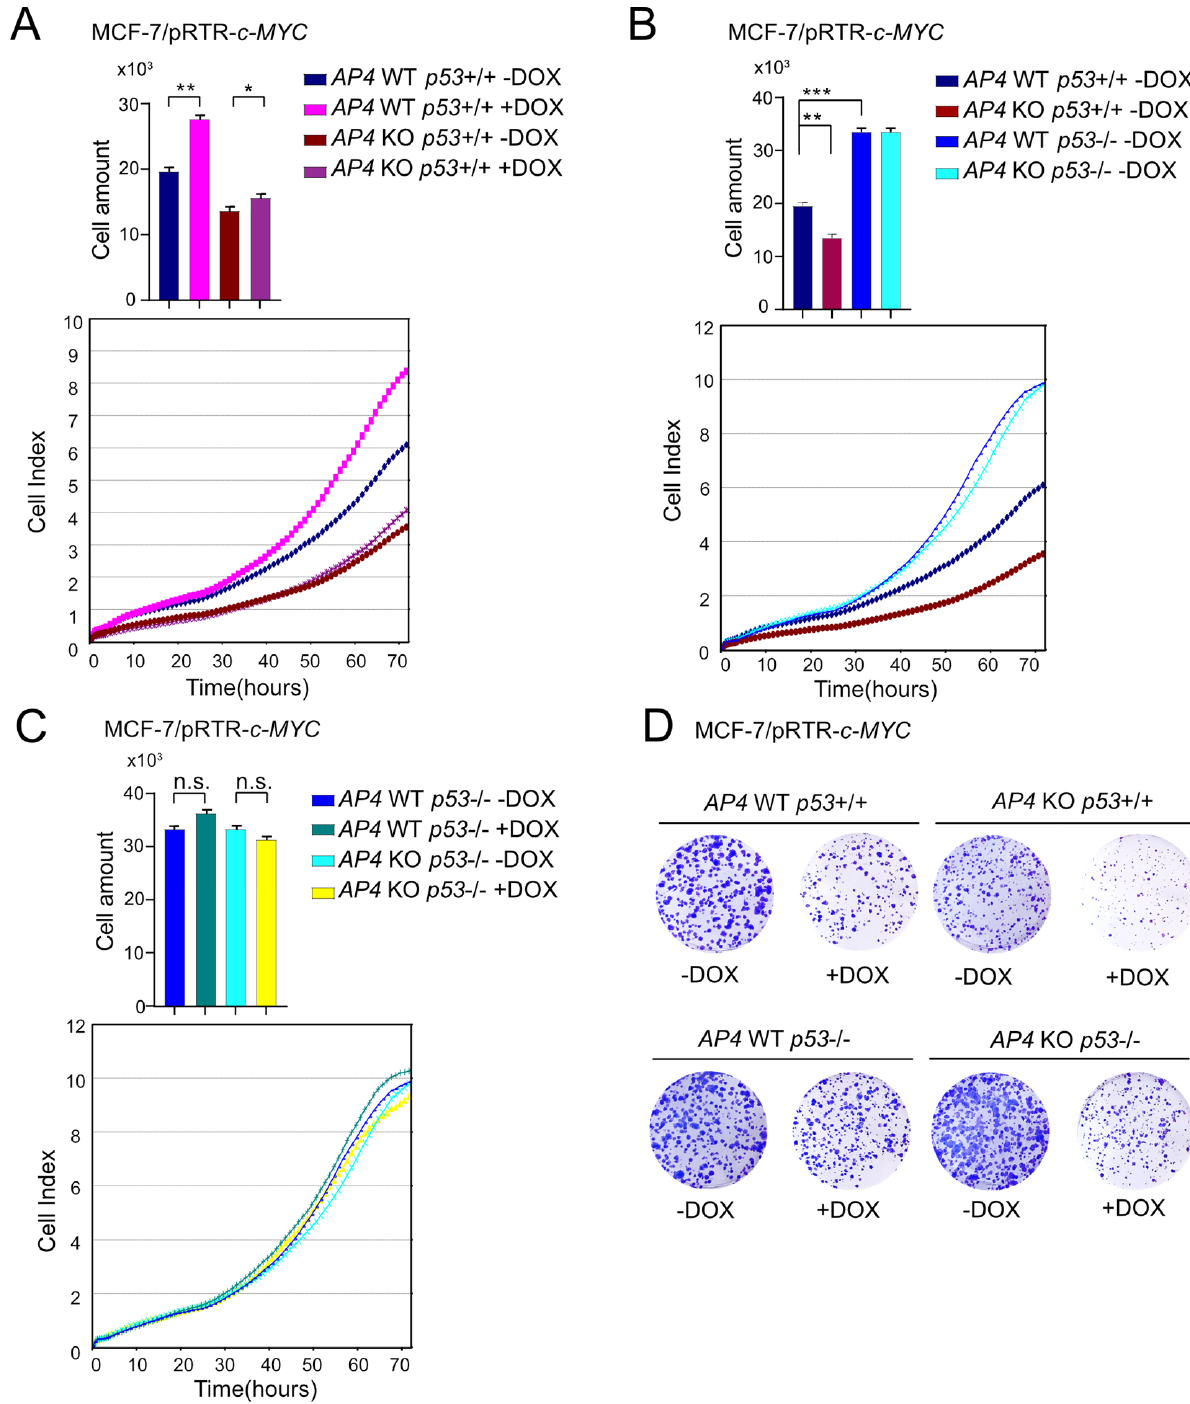
Figure 2. Effects of AP4 - and p53 -deficiency on basal and c-MYC-induced cell proliferation. ( A – C ) Cell proliferation of the indicated cell lines was determined by impedance measurement. Cell numbers were determined at 72 h. Results are presented as the mean +/ − SD with *: p < 0.05, **: p < 0.01, ***: p < 0.001, n.s.: no significance. ( D ) Colony formation assays with the indicated cell lines. Cells are shown 14 days after seeding.